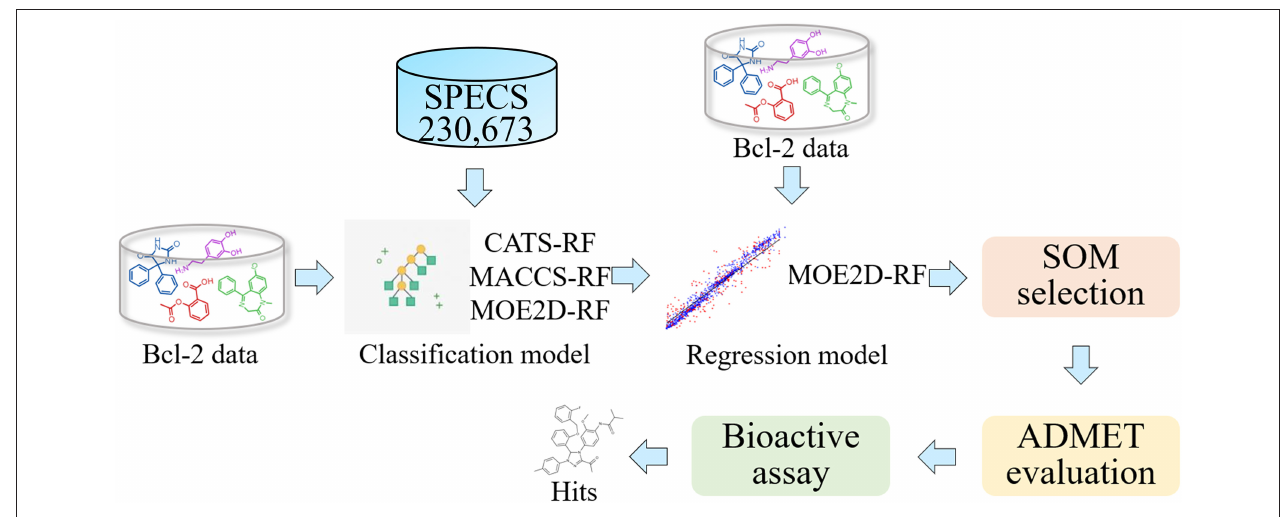
FIGURE 1 | Flowchart of the virtual screening